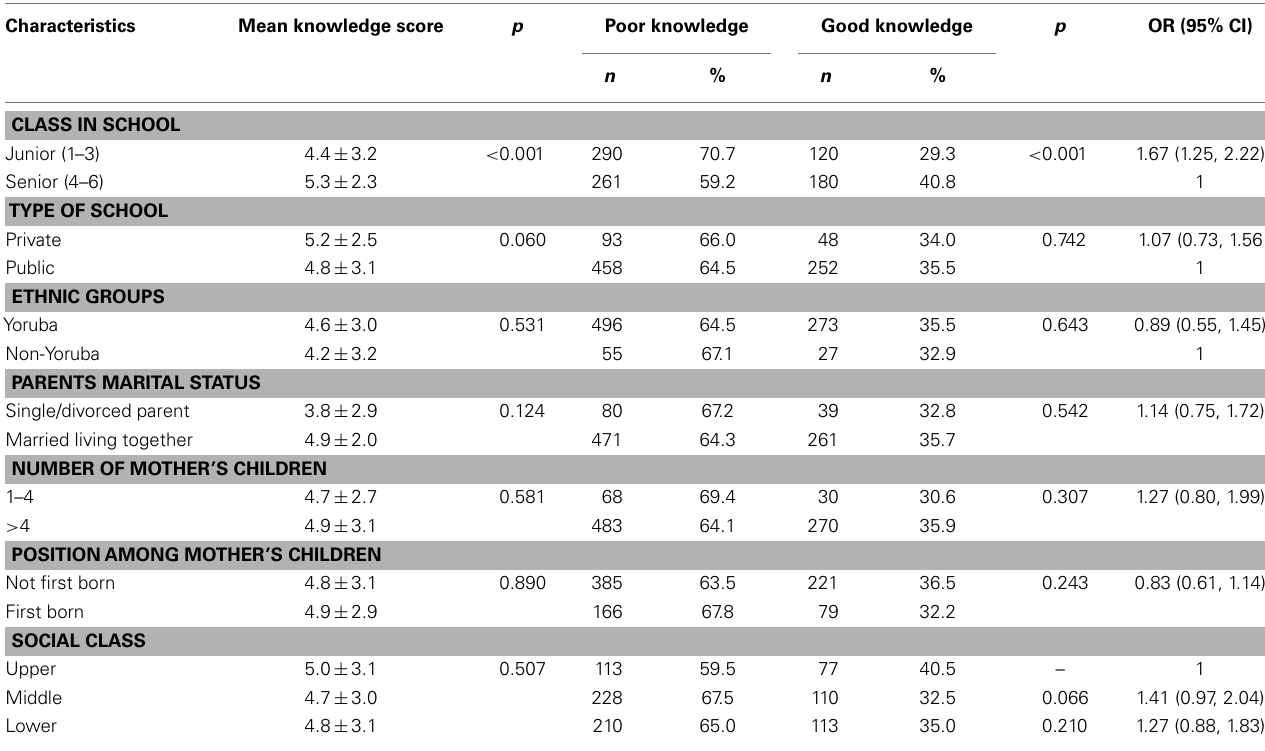
Table 3 | Knowledge scores of the adolescents about tetanus compared by socio-demographic variables